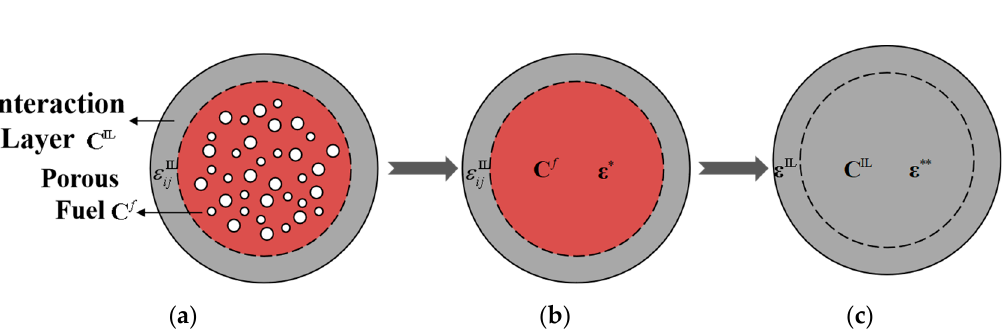
Figure 3. Double transformations according to the equivalent inclusion method. ( a ) A porous fuel particle surrounded by interaction layer; ( b ) An homogeneous equivalent inclusion surrounded by interaction layer after the first transformation; ( c ) An homogeneous equivalent inclusion after the second transformation.